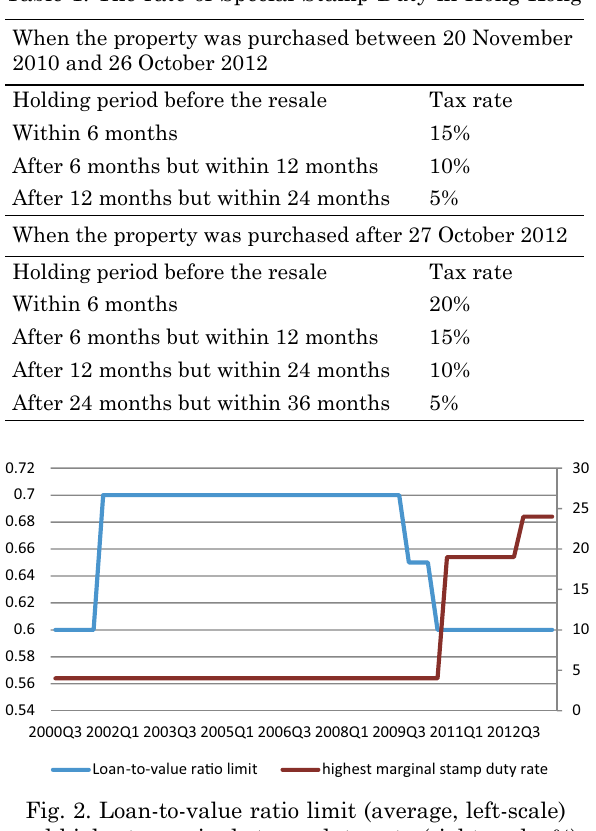
fig. 2. loan-to-value ratio limit (average, left-scale) and highest marginal stamp duty rate (right-scale, %) Source : Hong Kong Monetary